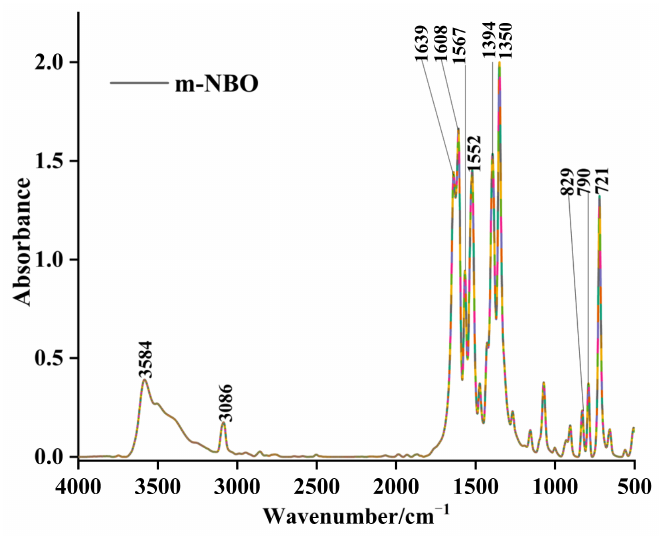
Figure 3. FTIR of organic-depressant